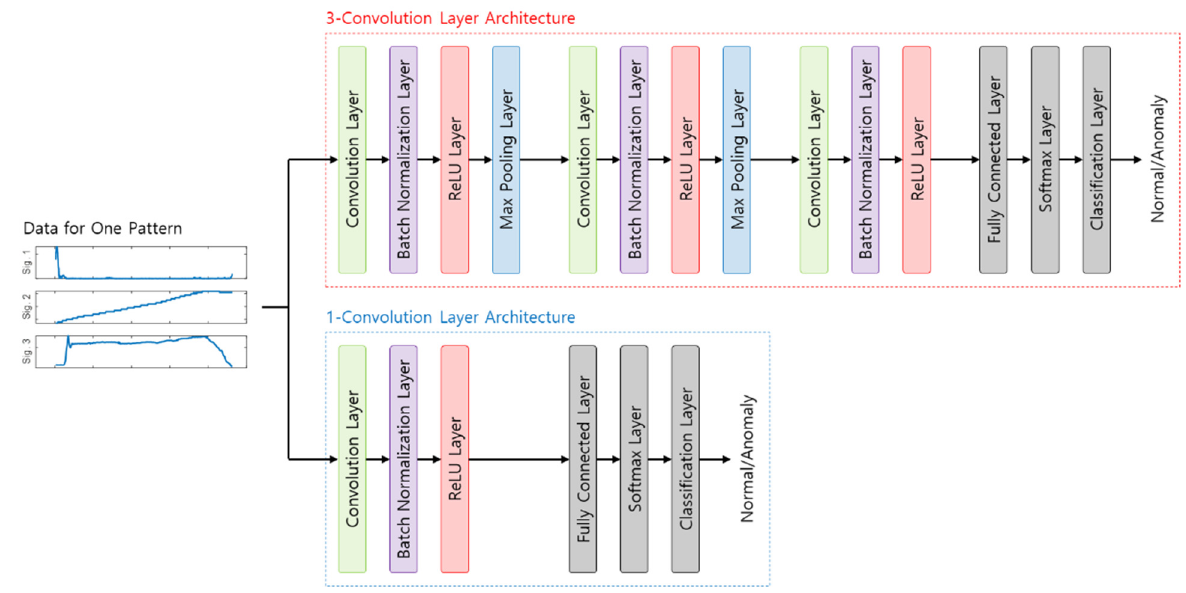
Figure 10. CNN-based anomaly detection model training architecture. Table 6. Convolutional layer hyperparameter setting.